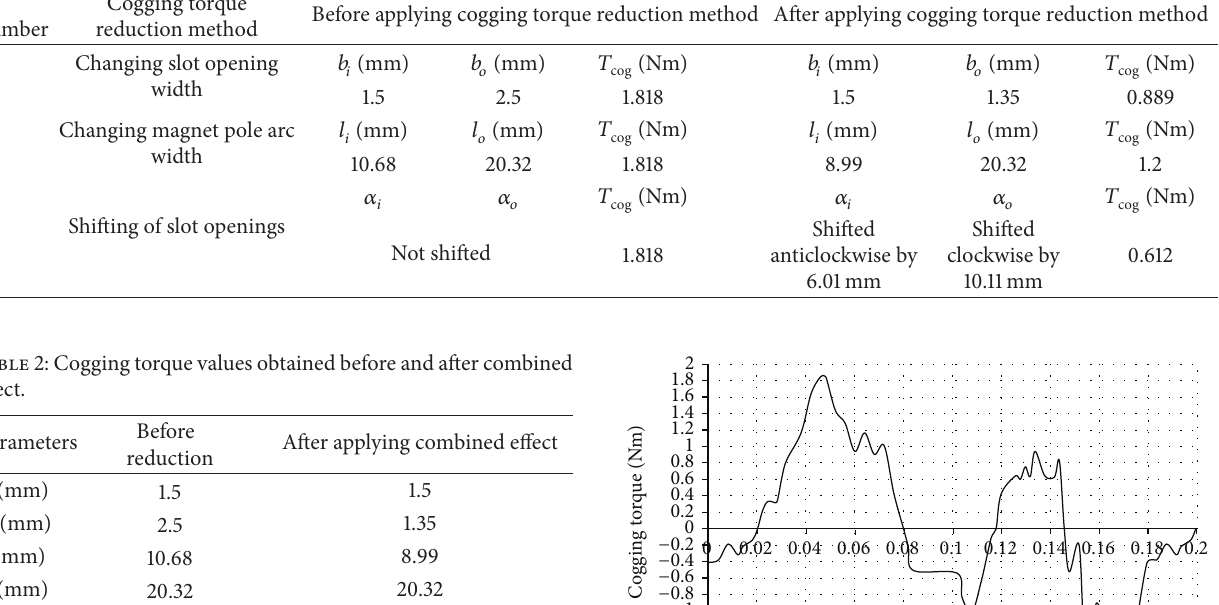
Table 1: Cogging torque values obtained before and after applying the different cogging torque reduction methods individually. S.